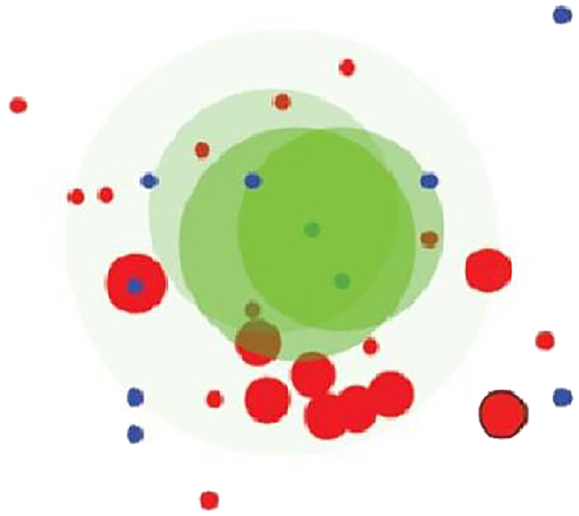
Figure11: Bubblemaprepresentationoftheresultsofthree biclustering algorithms